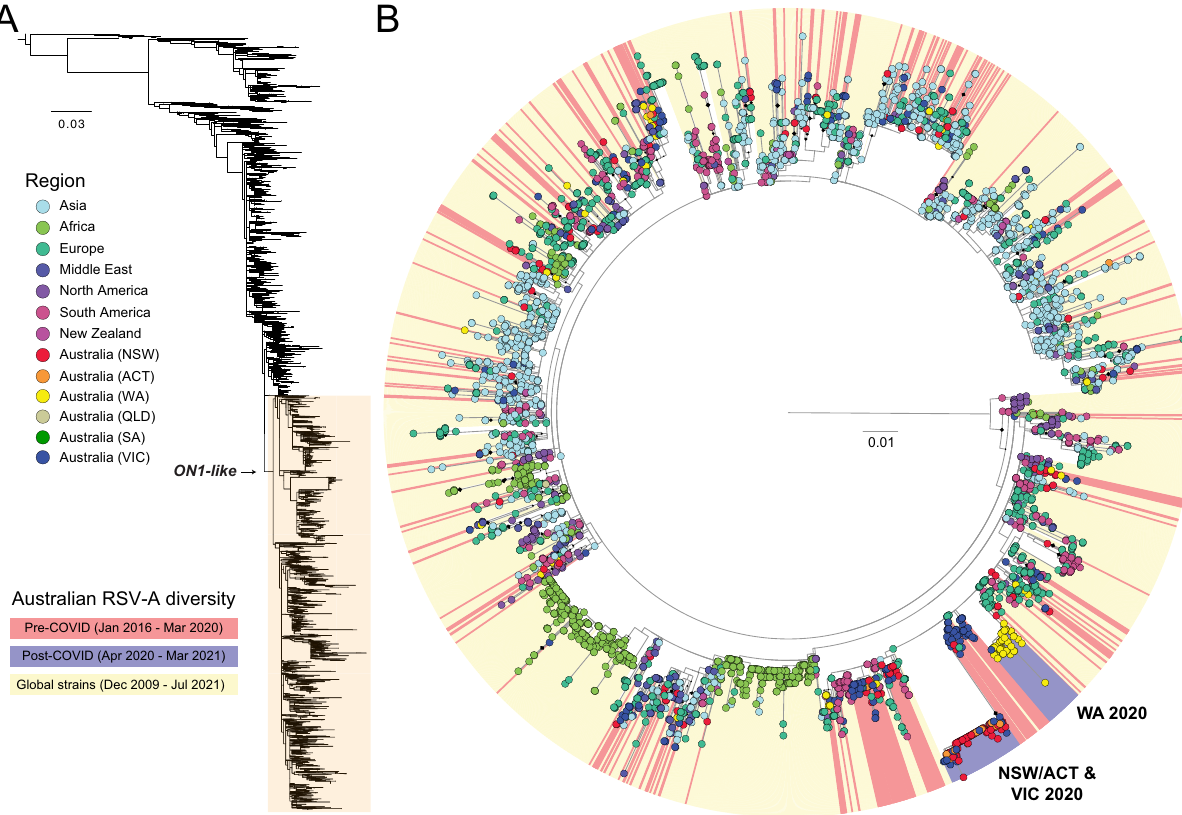
Fig. 3 Phylogenetic analysis of global and Australian RSV-A glycoprotein sequences. A RSV-A sequences in this study were aligned with all available RSV-A sequences from NCBI GenBank. The glycoprotein coding region was extracted, and sequences less than 300 nt were removed. B A detailed examination of recently circulating ON1-like viruses showed only two pre-COVID-19 lineages (coloured red) survived into the post-COVID-19 period (blue). These two lineages were associated with outbreaks in NSW/ACT and WA in late 2020, and VIC in early 2021. No sequences sourced globally (yellow) were found to be related to the these lineages, suggesting the sources remain unknown. Australian states — New South Wales (NSW), Australia Capital Territory (ACT), Western Australia (WA) and Victoria (VIC), South Australia (SA) and Queensland (QLD) — and globally-derived sequences are coloured according to the key provided. Diamonds at nodes indicate bootstrap support values >70%. Branches are proportional to the number of nucleotide substitutions per